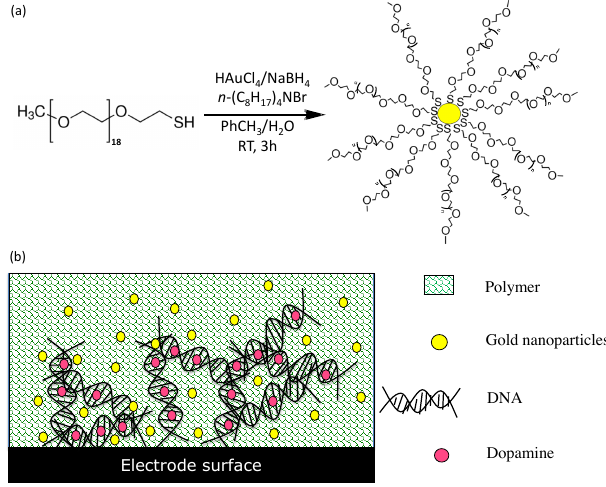
Figure S5. (a) Gold nanoparticles synthesis using modified Brust method with polyethylene glycol ligand and (b) electrode surface functionalization principle using gold nanoparticles.